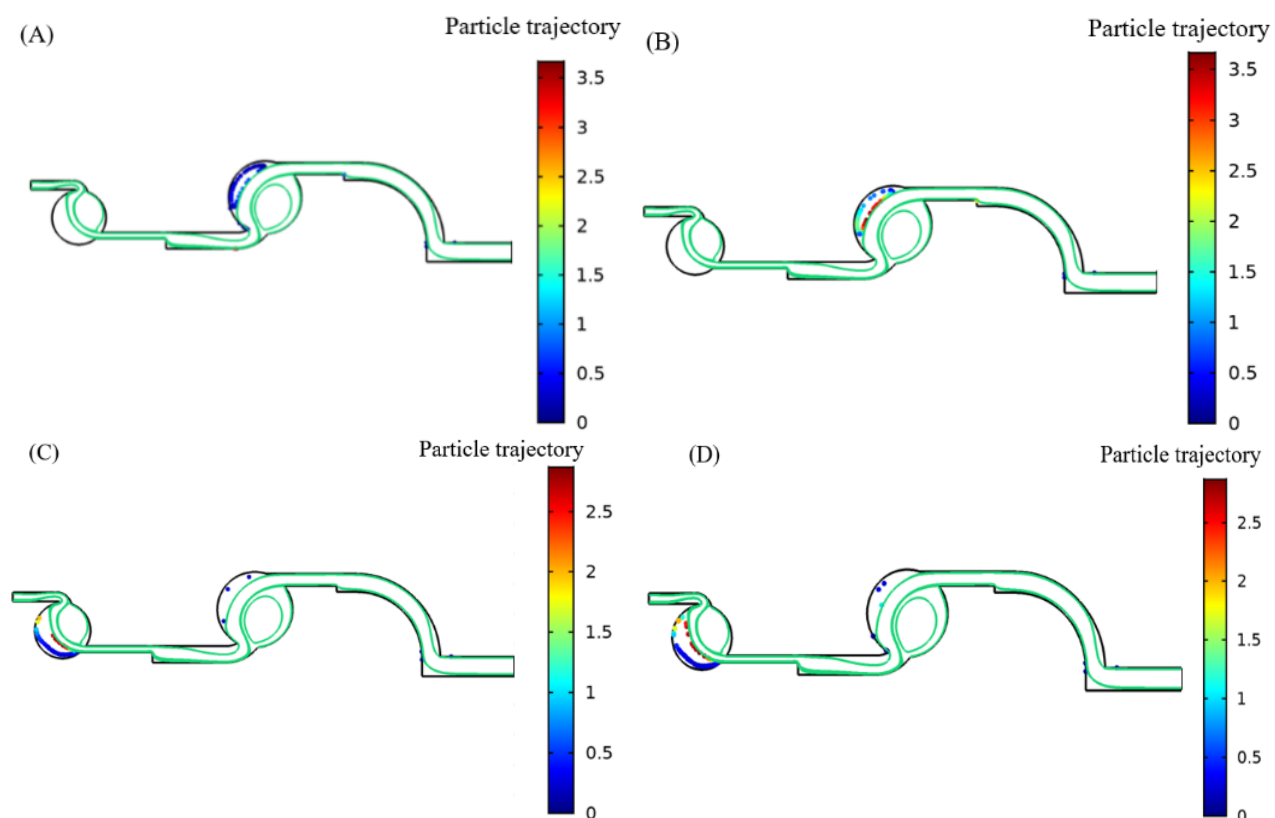
Figure 6. Statistical graph of particle enrichment imitation rate: ( A ) 6 μ m collection effect; ( B ) 8 μ m collection effect; ( C ) 3 μ m collection effect; ( D ) 5 μ m collection